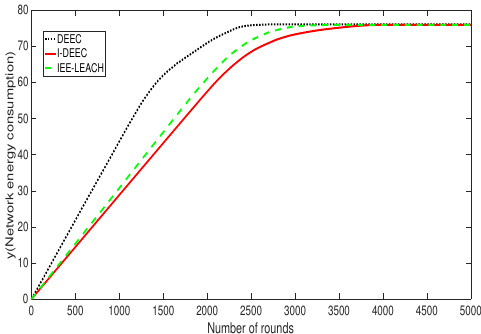
Figure 13. Comparison of network energy consumption.